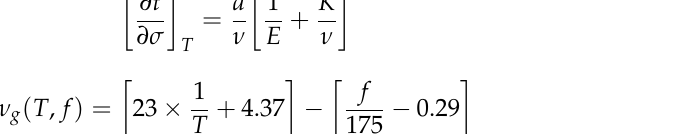
Figure 12. Temperature effect on PZT amplitude [126].